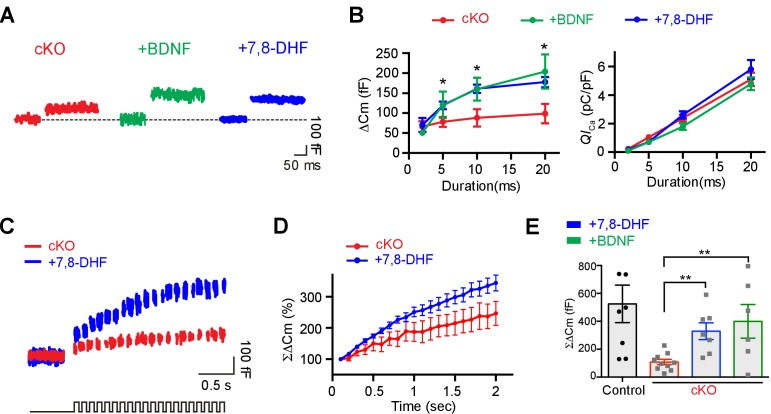
Application of extracellular BDNF or 7,8-DHF partially rescues the reduced exocytosis at calyx terminals in Bdnf cKO mice.(A) Representative traces of Cm (top) and ICa (middle) induced by 20 ms depolarization from –80 to 0 mV (bottom) at calyx terminals in Bdnf cKO mice (P9–13, red) in the presence of BDNF (100 ng/ml; green) or 7,8-DHF (20 μM; blue). (B) The duration of depolarizing pulses was plotted versus ΔCm (left) and QICa (right) for terminals from Bdnf cKO slices in the absence (red) and the presence of BDNF (green) or 7,8-DHF (blue). (C) Representative traces of Cm (top) induced by the train of 20 depolarizing pulses (10 ms, 10 Hz; bottom) from –80 to 0 mV in terminals from Bdnf cKO mice in the absence (red) or presence of 7,8-DHF (blue). (D) Summary of the normalized ΣΔCm relative to the stimulation time in the absence (red) or presence of 7,8-DHF (blue). (E) Summary of ΣΔCm of calyx terminals after the train of 20 depolarizing pulses (at 2 s) in the control slices (black) and in Bdnf cKO slices in the absence (red) and in the presence of BDNF (green) or 7,8-DHF (blue). Data are shown as the mean ± s.e.m. *p<0.05; **p<0.01 (unpaired t-test).